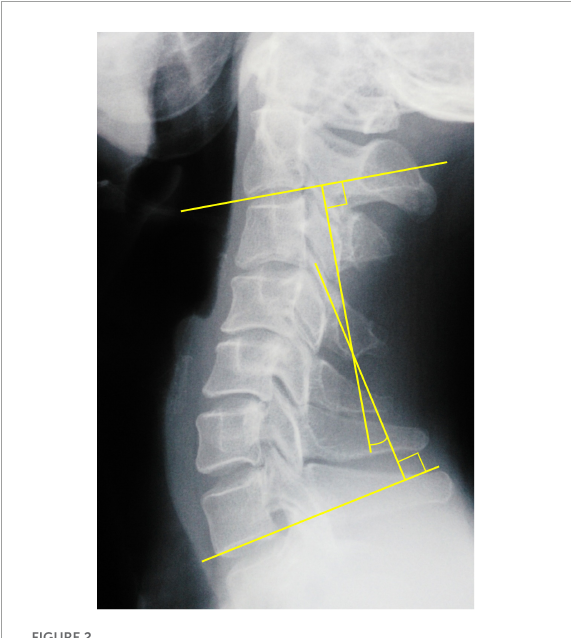
FIGURE2 C2-7 Cobb angle measurement.